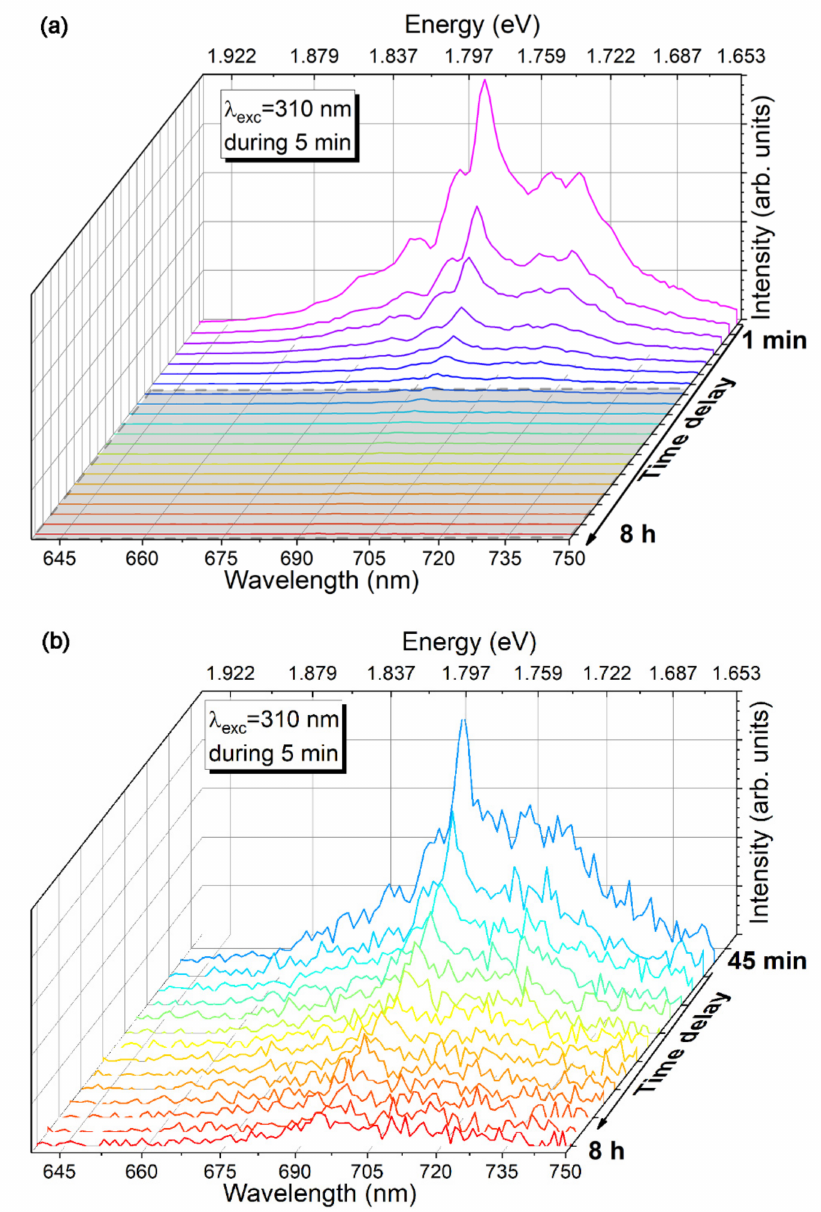
Figure 13. RT red/NIR persistent PL of ZGGO:Cr after illumination with 310 nm of a Xe lamp for 5 min. The grey zone in ( a ) is zoomed in ( b